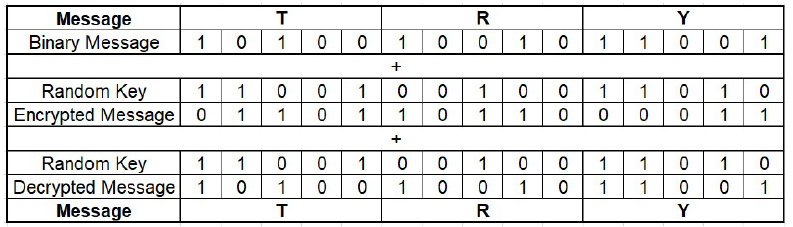
Figure 1. Example of an encryption of a binary message using a secure key. T, R, Y are alphabetic letters and their corresponding binary codes are the binary message.